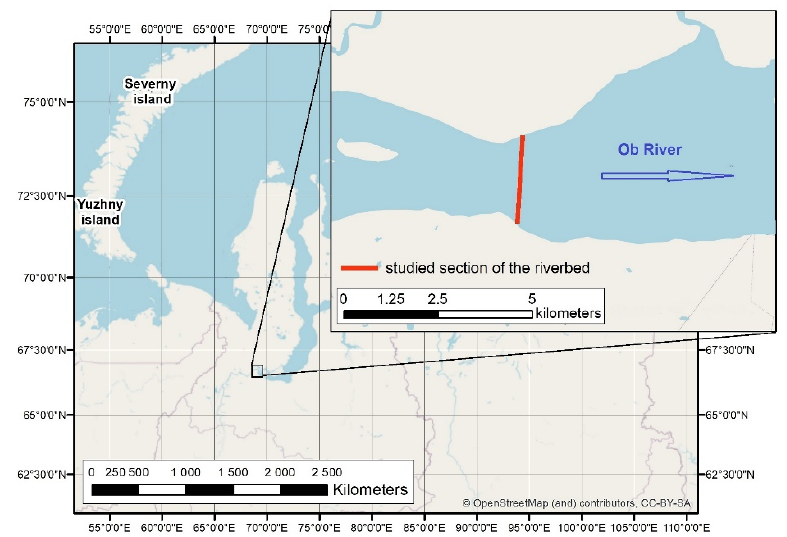
Figure 1. Overview scheme of the location of the study area in the lower reaches of the Ob River.